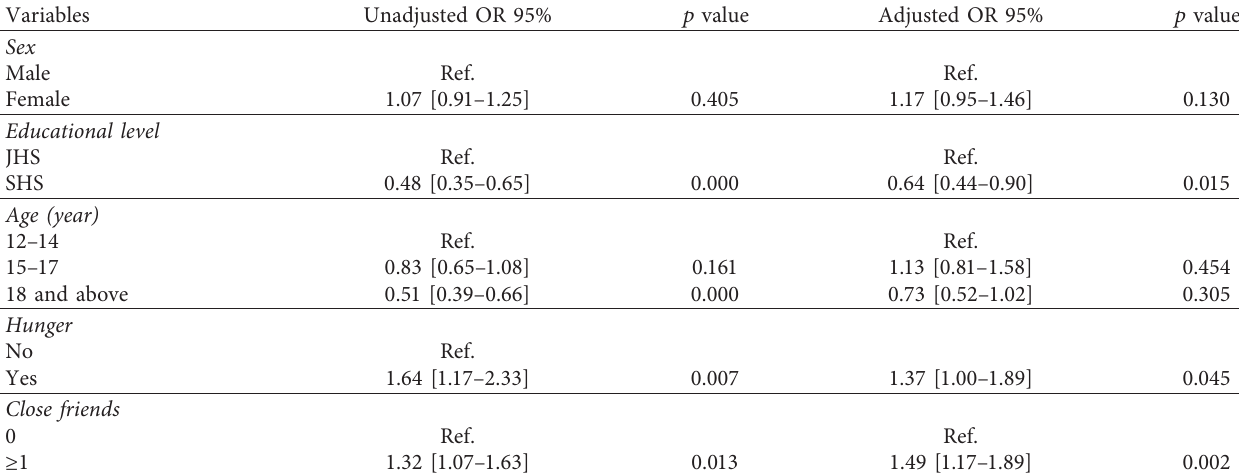
Table 4: Association between the significant variables and serious